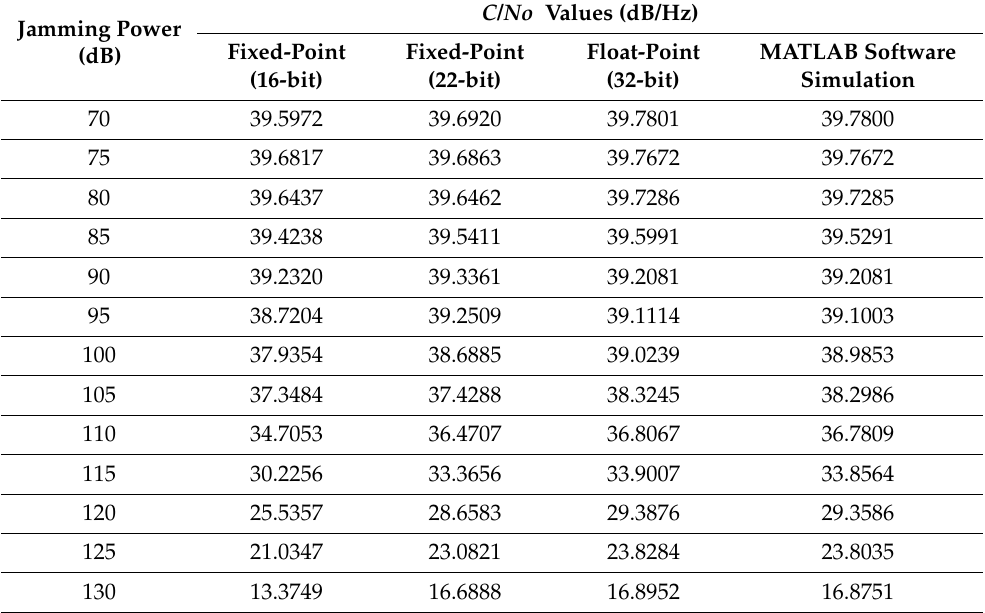
Table 3. Comparison of the ( C / No ) values of the 16, 22-bit (fixed-point), 23-bit (float-point), and MATLAB software simulation performances.